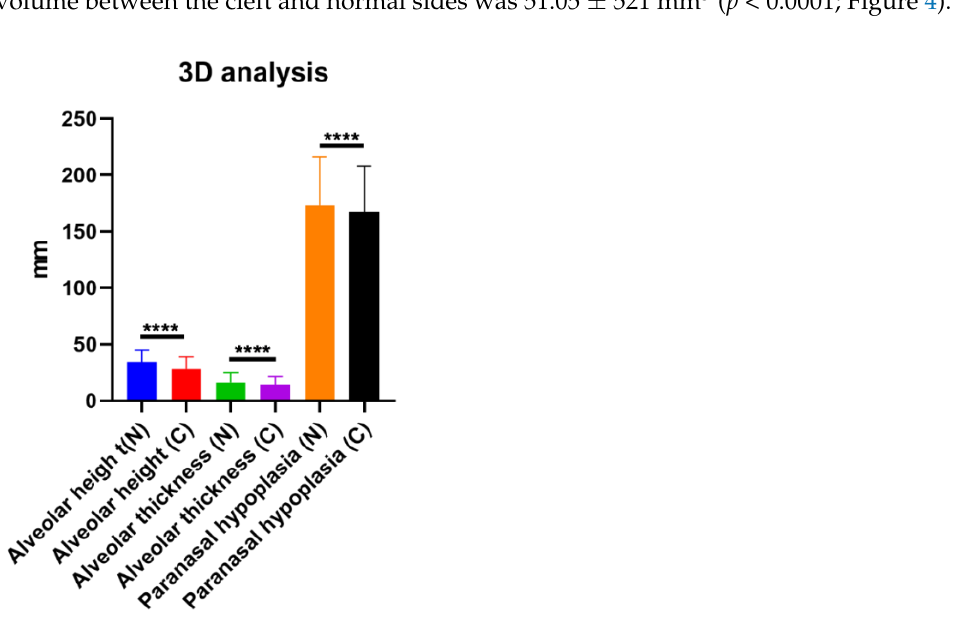
Figure 3. Differences in bony height, thickness, and paranasal hypoplasia between cleft and normal sides. **** p <